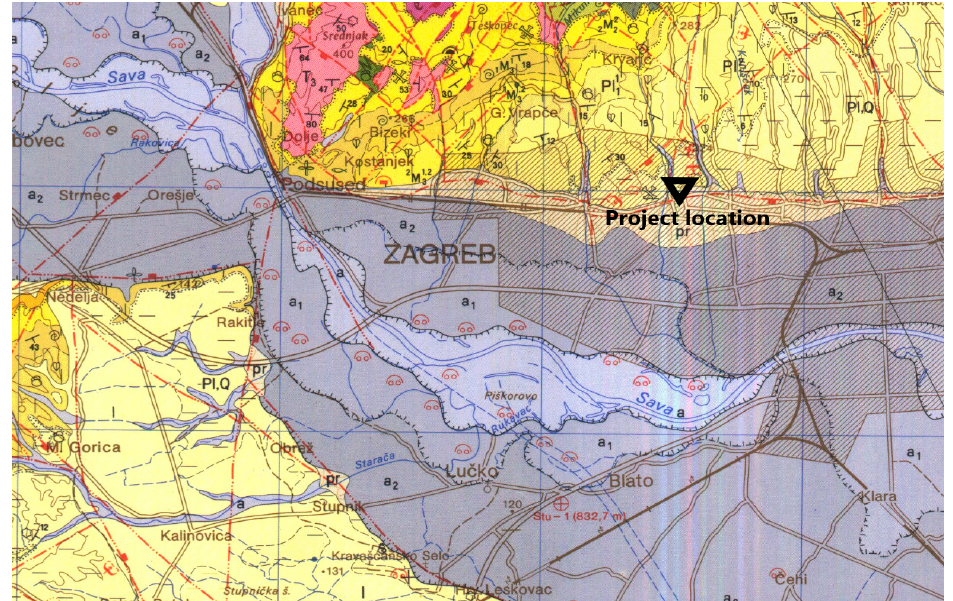
Figure 1. Detailed geological map with BHEs location and general lithology column of the project site.